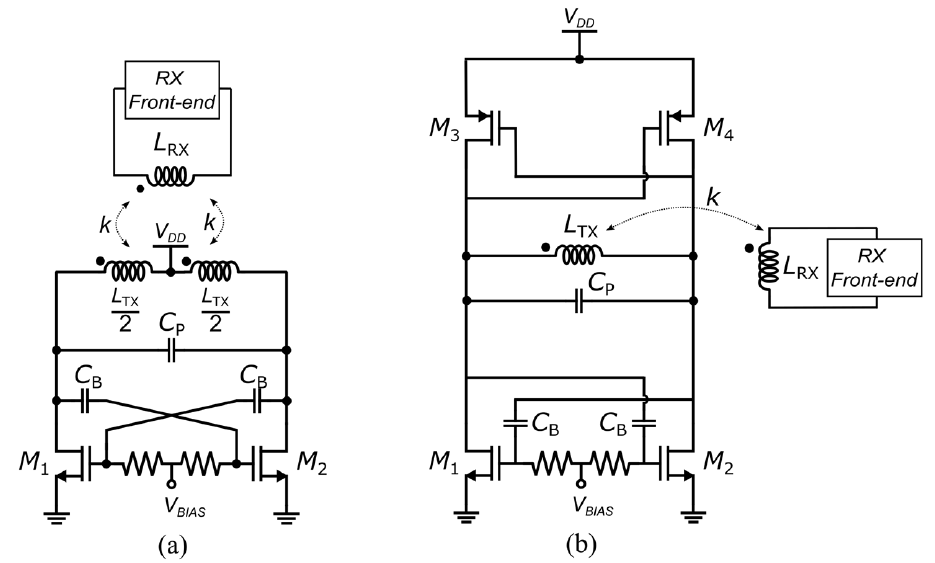
Figure 3. Simplified block-diagram of galvanic isolator based on RF coupling (single physical chan- nel).